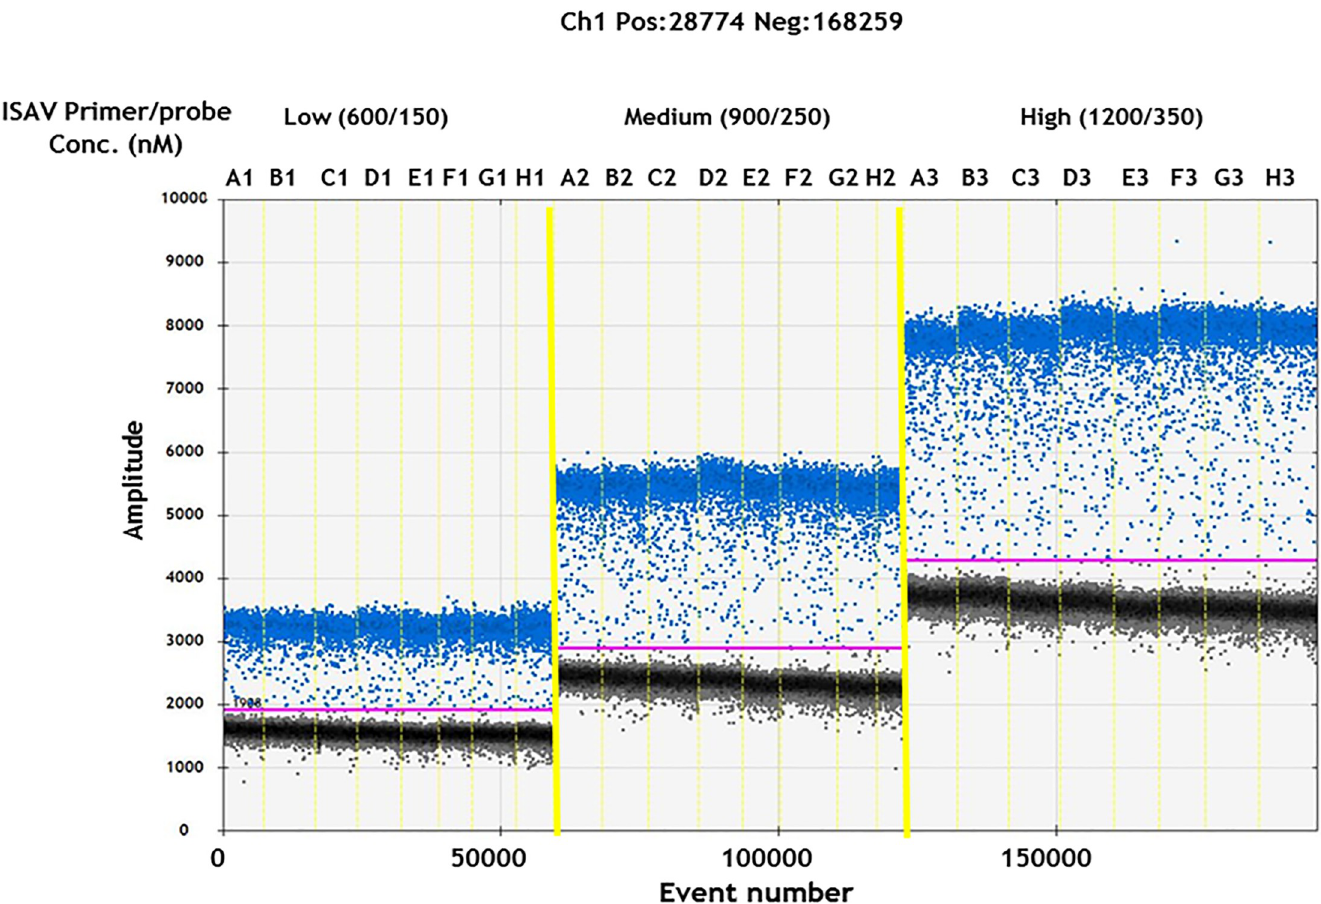
Fig 2. Optimization of the annealing temperatures and primer/probe concentration for detection of ISAV using RT-ddPCR. The RT-ddPCR amplitude plot is showing clusters of ISAV negative (black) and positive (blue) droplets. Lanes divided by vertical thin yellow lines (A1 –H1, A2 –H2 and A3 –H3) represent the gradient of annealing temperatures: 63, 62.4, 61.4, 59.9, 58.1, 56.5, 55.6 and 55 o C. Lanes divided by thick yellow lines represent the gradient of three following primers/probe concentrations: low (600/150), medium (900/250), and high (1200/350 nM). The pink line represents the threshold discriminating droplets.